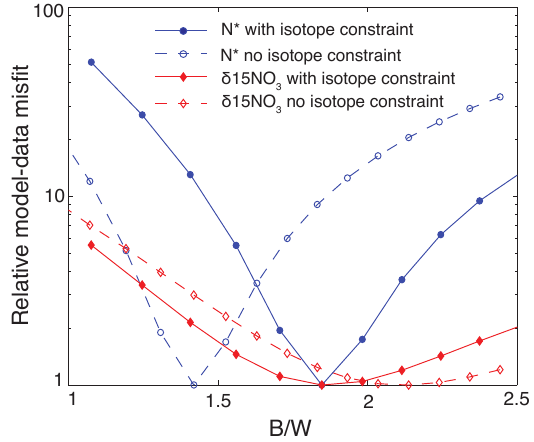
Fig. 8. Sensitivity of model-data misfit to partitioning of denitrifica- tion between sediments and water column. We start with a model so- lution in which only N ∗ is used as a constraint (open symbols), and one in which both N ∗ and δ 15 NO 3 are used as constraints (closed symbols). We then vary B/W by adjusting the parameters determin- ing the rate of benthic denitrification, while keeping all other param- eters and the total denitrification rate constant. These experiments use the model configuration with (cid:15) fix = 0, (cid:15) b = 0, and σ DON = 1 / 4 .